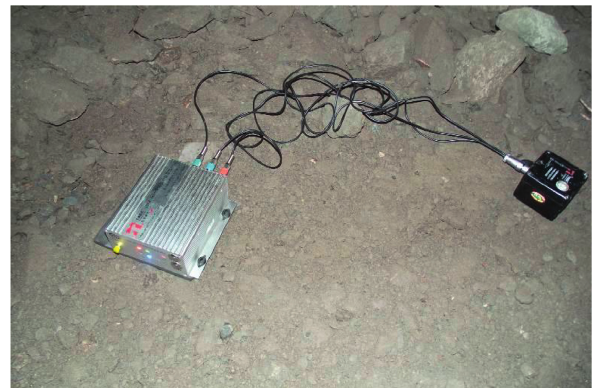
Figure 8: Ubox-5016 blasting vibration